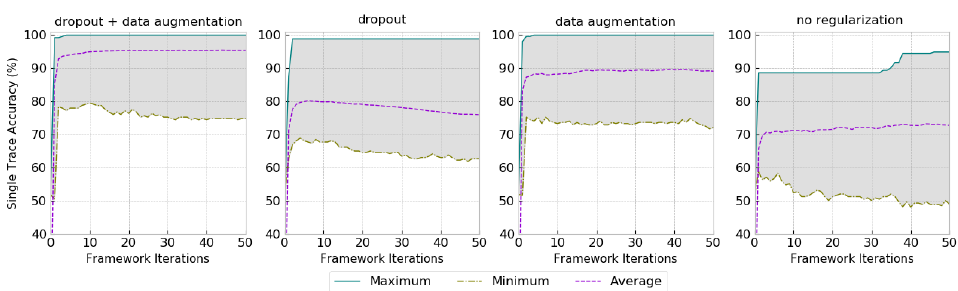
Figure 15: Fixed CNN hyperparameters: minimum, maximum, and average single trace accuracy with iterative framework on the cswap-pointer dataset and attacking the sample interval range from 550 to 800 of all sub-traces.